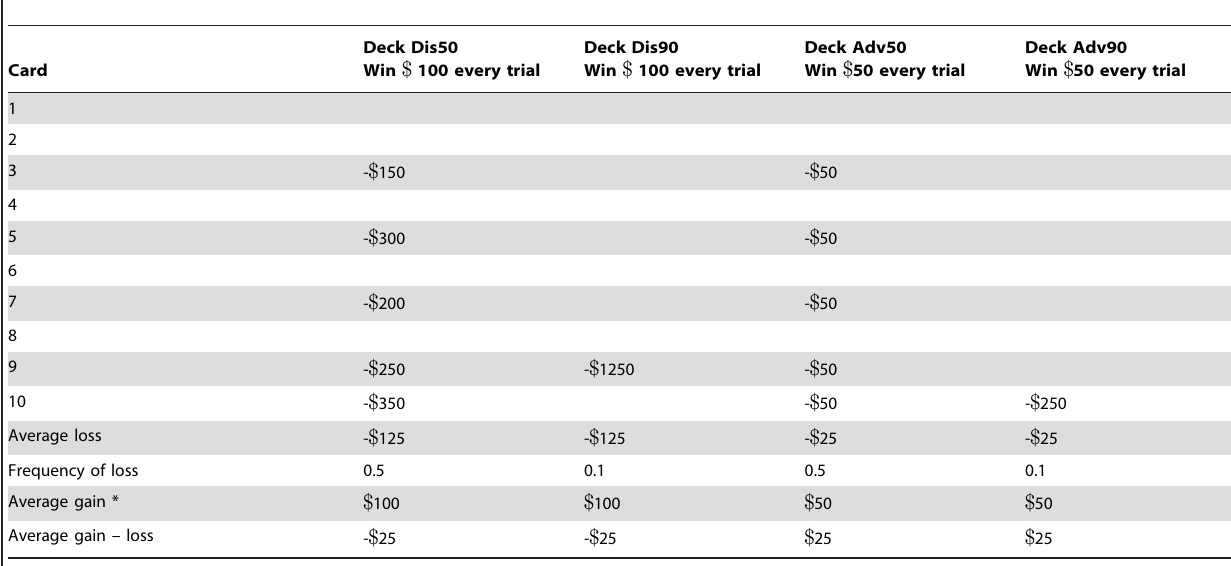
Table 1. The schedule of rewards and penalties in the four decks of cards of the IGT, as introduced in [20]: The first block of 10 selections from each of the decks (out of 6